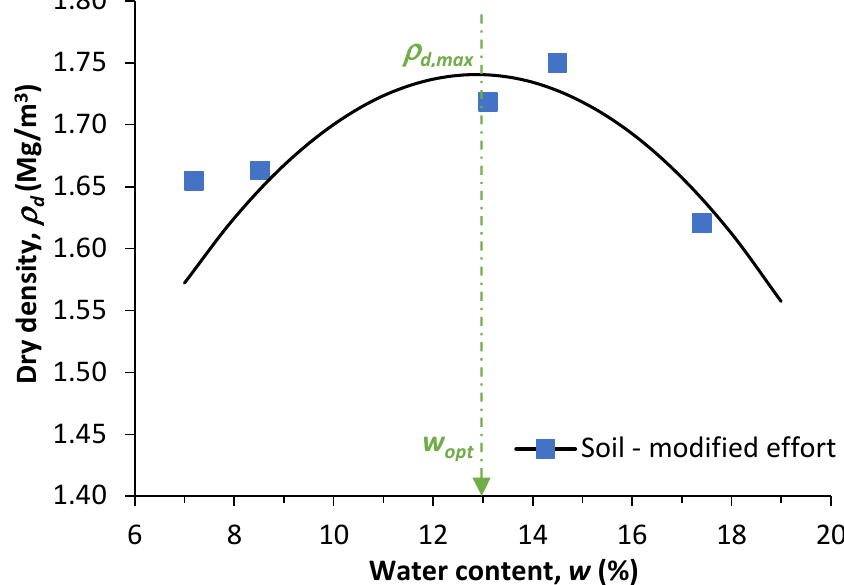
Figure 4. Proctor test results of soil with modified compaction effort. The moulding points, with less or equal compaction energy than the modified Proctor energy, were chosen at the previously determined optimum water content level of the soil. These moulding points consisted of applying an increasing number of blows per layer: 10 (E1), 15 (E2), 20 (E3) and 25 (E4) blows on CBS mixtures with a water content of 13%, as explained in detail in Section